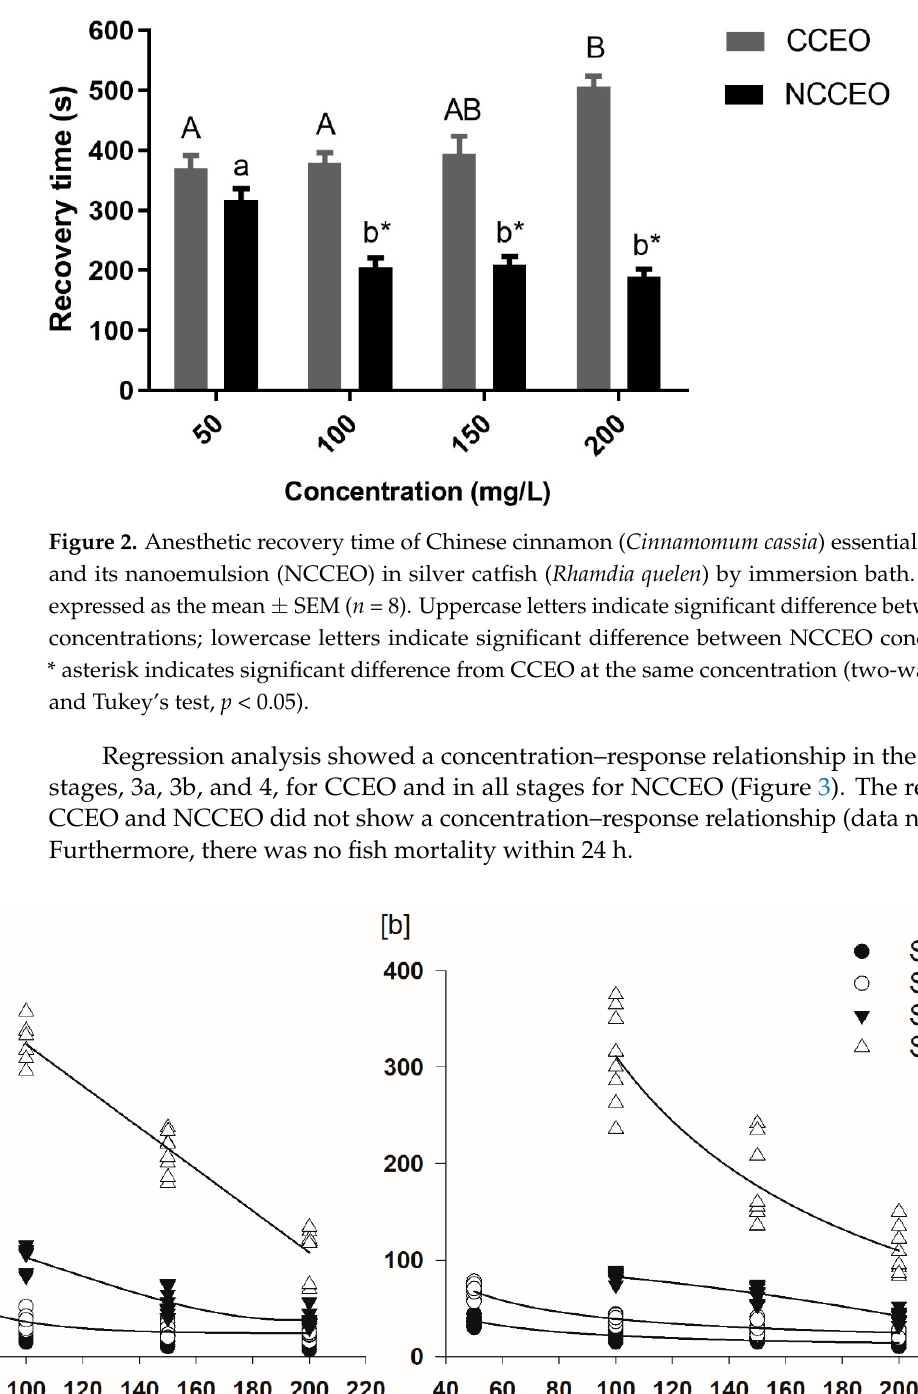
Figure 1. Anesthetic induction time with Chinese cinnamon ( Cinnamomum cassia ) essential oil (CCEO) and its nanoemulsion (NCCEO) in silver catfish ( Rhamdia quelen ) by immersion bath. ( a ) Stage 2; ( b ) stage 3a; ( c ) stage 3b; and ( d ) stage 4. Values are expressed as median ± interquartile range ( n = 8). * Asterisk indicates significant difference from CCEO at the same concentration (Mann–Whitney test, p < 0.05).